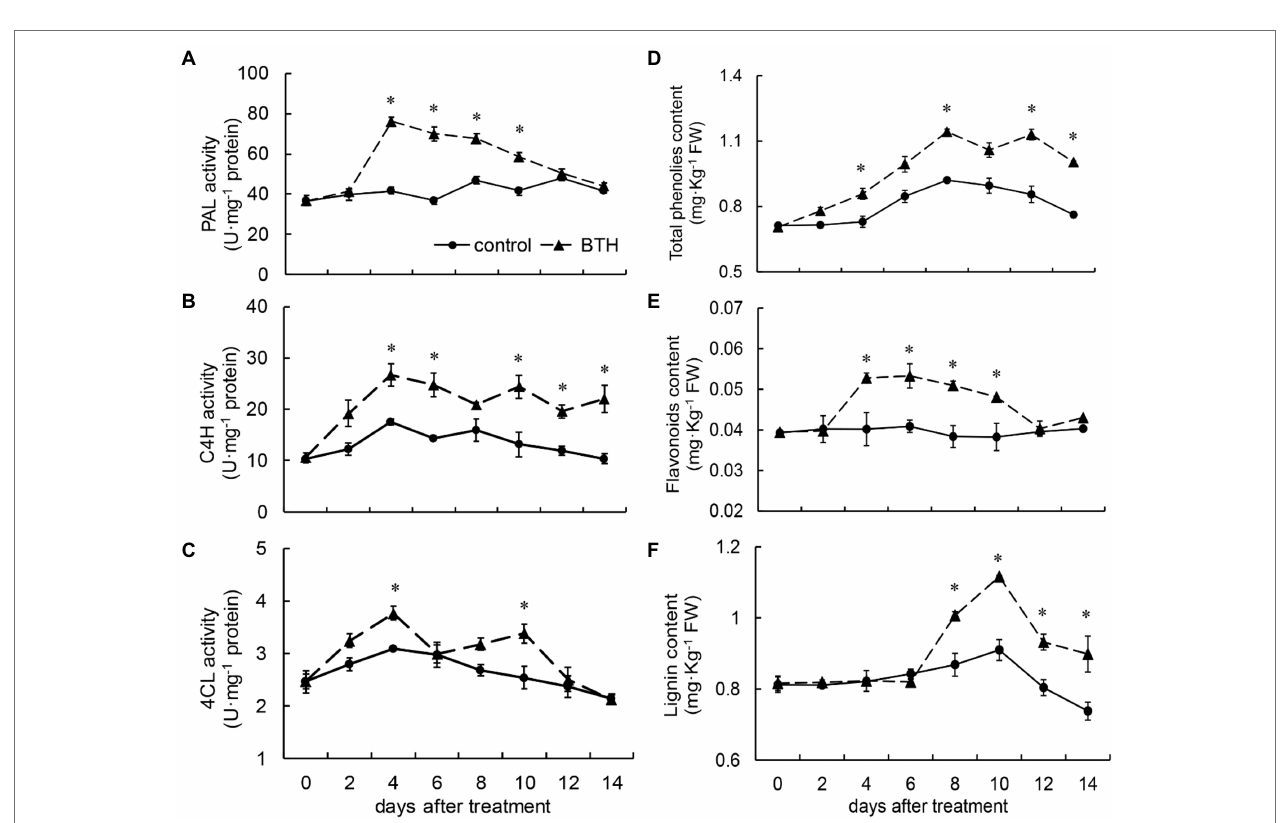
FIGURE 4 | Changes in the activities of phenylalanine ammonia lyase (PAL; A ), cinnamate 4-hydroxylase (C4H; B ), 4-coumarate-CoA ligase (4CL; C ), and the content of total phenolic (D) , flavonoids (E) , and lignin (F) in R. roxburghii fruit after BTH treatment during low temperature storage. The significant differences at a level of 0.05 by LSD between the control and BTH-treated fruit are indicated by asterisks (*). Vertical bars represent the standard errors of the means (±SE).